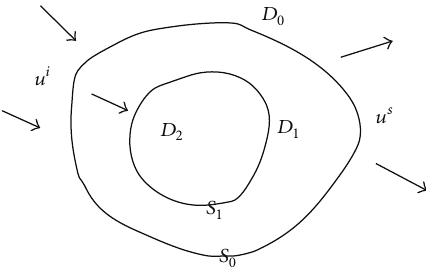
Figure 1: Multilayered scattering